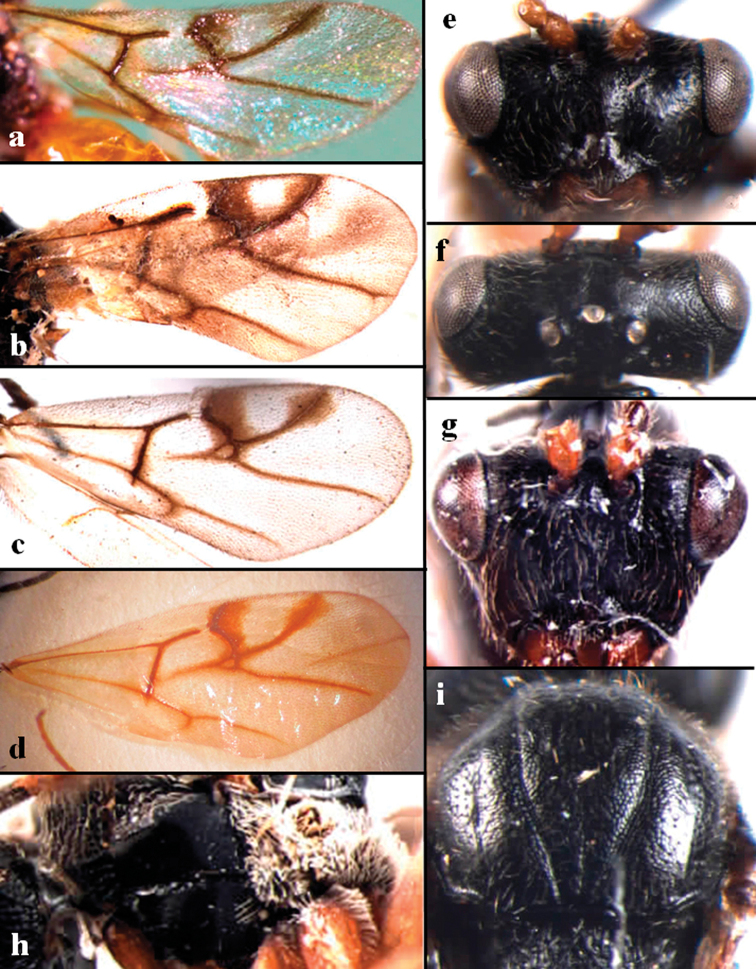
a forewing of D.
flaviabdomenisb forewing of D.
hunanensisc forewing of D.
minoriabdomenis, and d forewing of D.
nr
japonicae head in frontal view of D.
nr
japonica (reused from Wang et al. 2013) f head in dorsal view of D.
nr
japonica (reused from Wang et al. 2013) g head in frontal view of D.
hunanensish lateral mesosoma of D.
minoriabdomenisi mesoscutum of D.
nr
japonica.